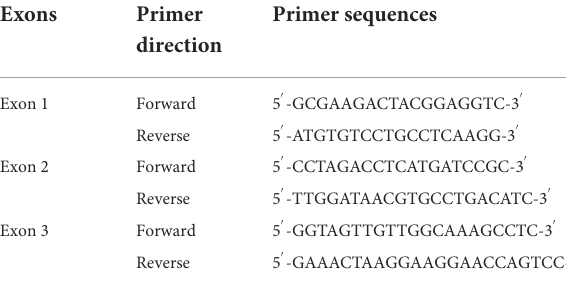
TABLE 1 Primer sequences of exons of VHL